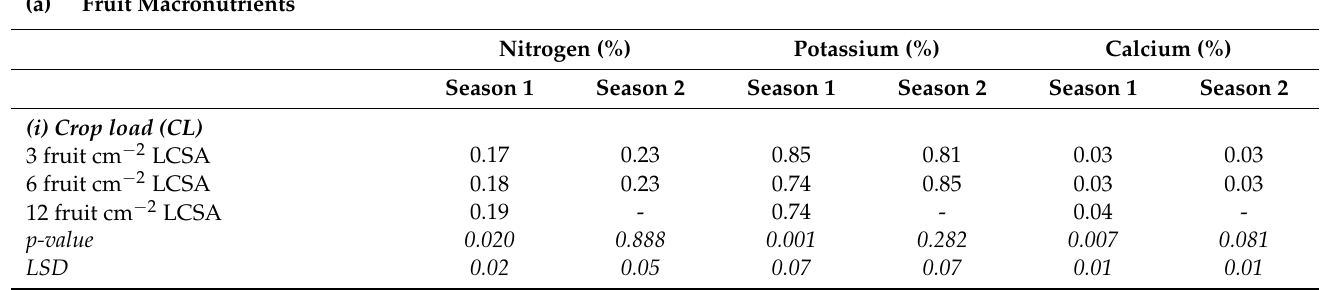
Table 3. Effect of thinning regime (artificial bud extinction (ABE) or hand thinned (HT)) and crop load (3, 6, or 12 fruit cm − 2 limb cross-sectional area (LCSA)) on fruit macronutrient and micronutrient concentrations in seasons 1 and